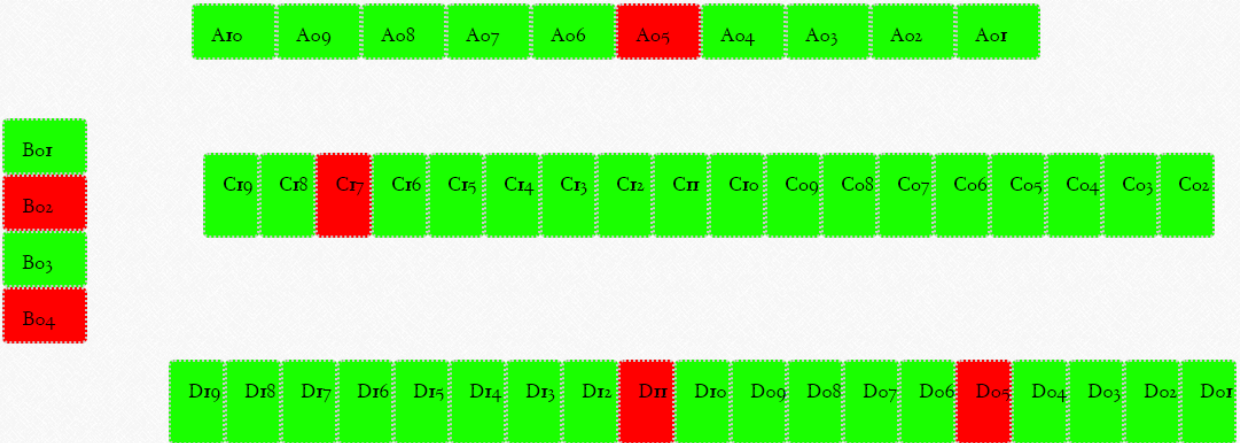
Figure 15. Parking Status: Red for occupied spots and green for vacant ones.